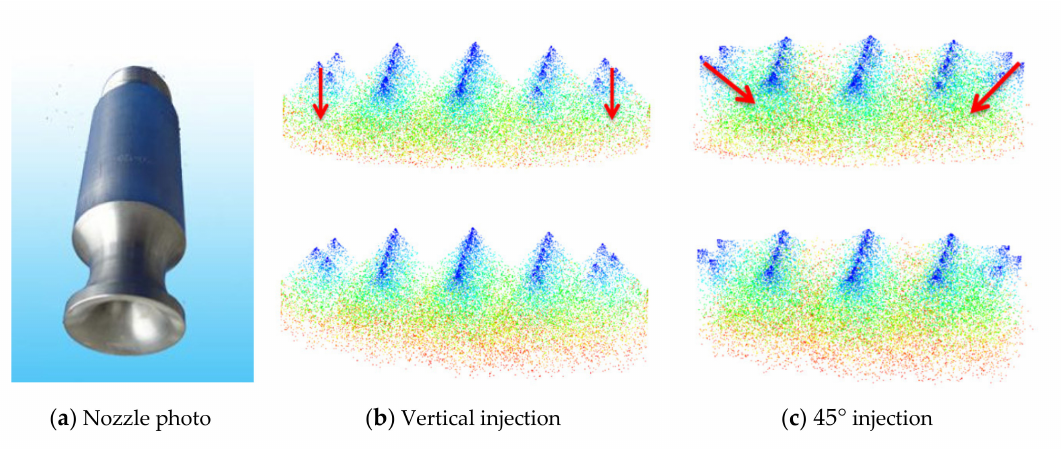
Figure 17. Nozzle photo and injection direction.